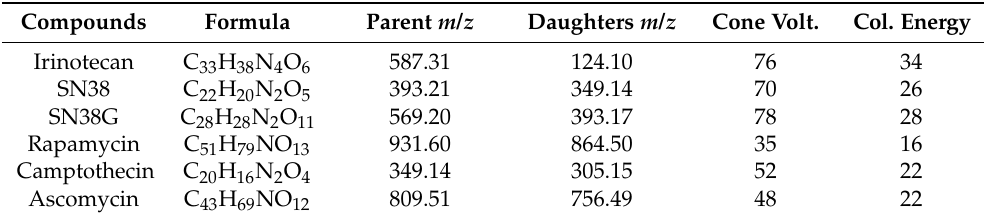
Table 2. Optimized MRM parameters of irinotecan, SN38, SN38G, rapamycin, camptothecin, and